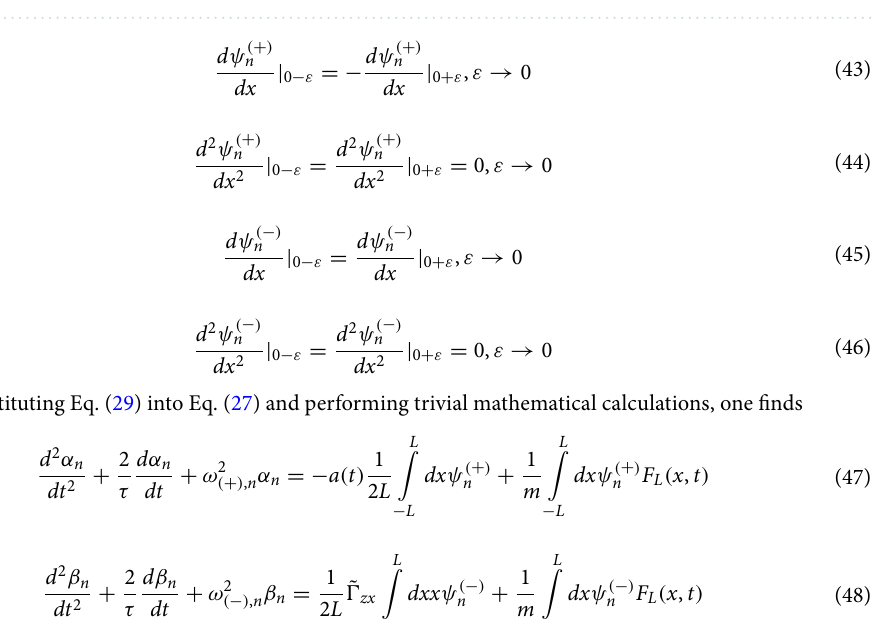
Figure 6. ( a ) Symmetric eigenmodes of free-hinged-hinged-hinged-free beam (1st—black, 2nd—red, 3rd— blue, 4th—magenta); ( b ) Mirror-symmetric eigenmodes of free-hinged-hinged-hinged-free beam (1st—black, 2nd—red, 3rd—blue,